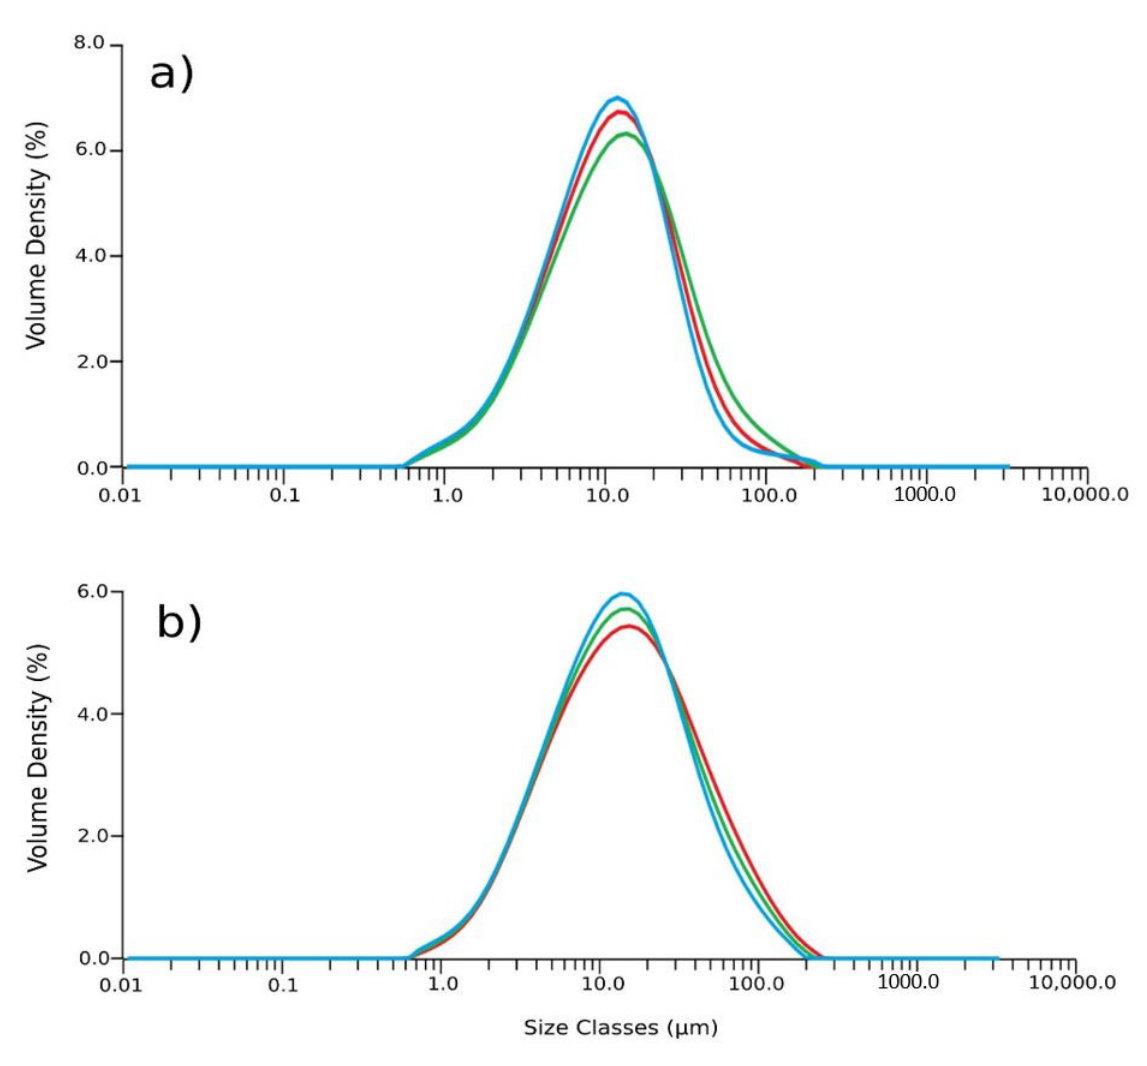
Figure 4. Particles’ size distribution of aggregates with ( a ) 10% w / w of coating and ( b ) 5% w / w of coating. MA show a good magnetic saturation (M) at room temperature and 20KOe (Figure 5a). MA with 5% w / w of coating have a M of 22.7 emu/g, while the those with 10% of coating have an M of 19.5 emu/g. This was expected indeed, since the MA with 10% of coating have more non-magnetic mass on them. The coercivity measured was 28.5 Oe and 37.6 Oe, respectively, for MA with 5% and 10% of coating (Figure 5b); thus, these materials have a superparamagnetic-like